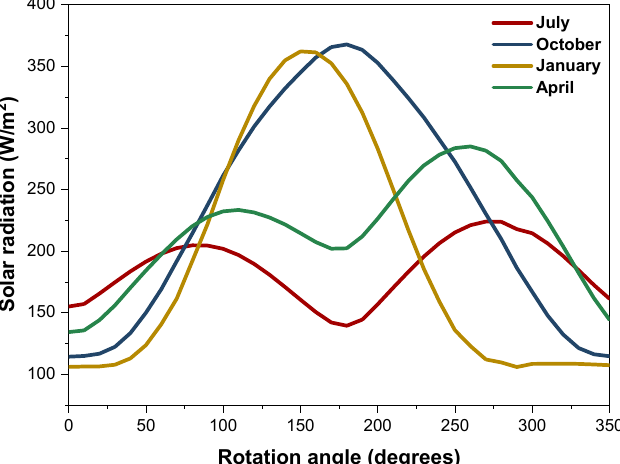
Figure 13. Relationship between average G VT on building façades and building.